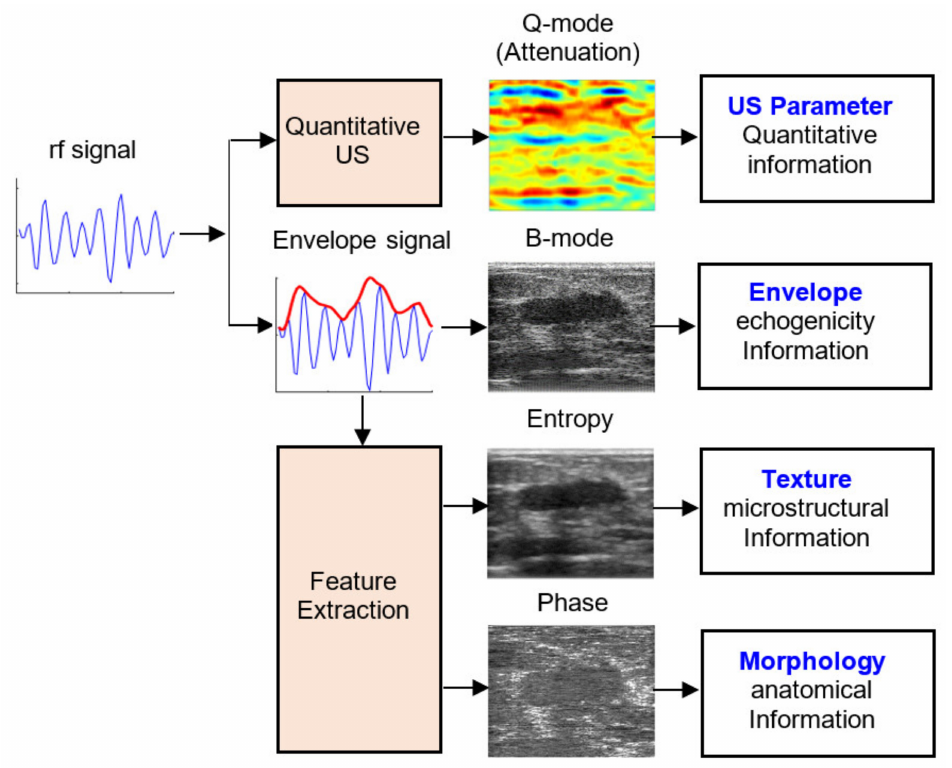
Figure 4. Overall scheme of the multiple parametric images generated from RF signals. The envelope signal (red) is calculated from the rf signal (blue) using the Hilbert